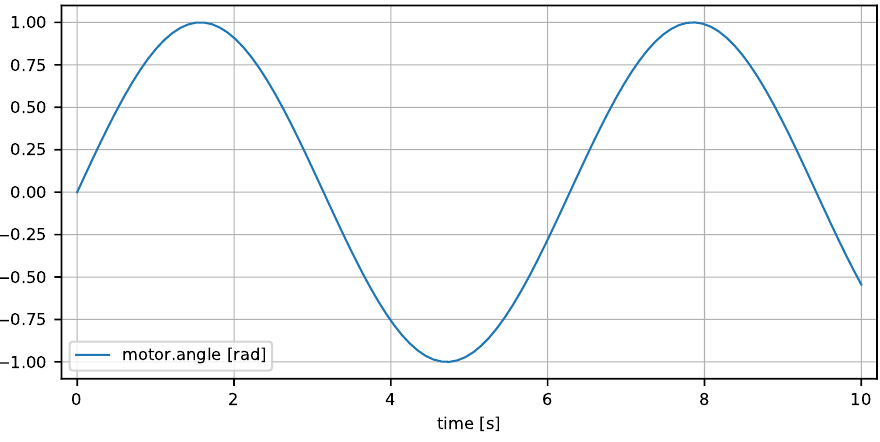
Figure 1. Plot of simple Signal Table of Listing